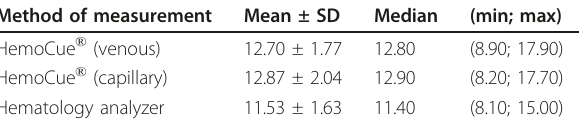
venous sample, HemoCue ® capillary sample, and automated hematology analyzer (g/dl) Method of measurement